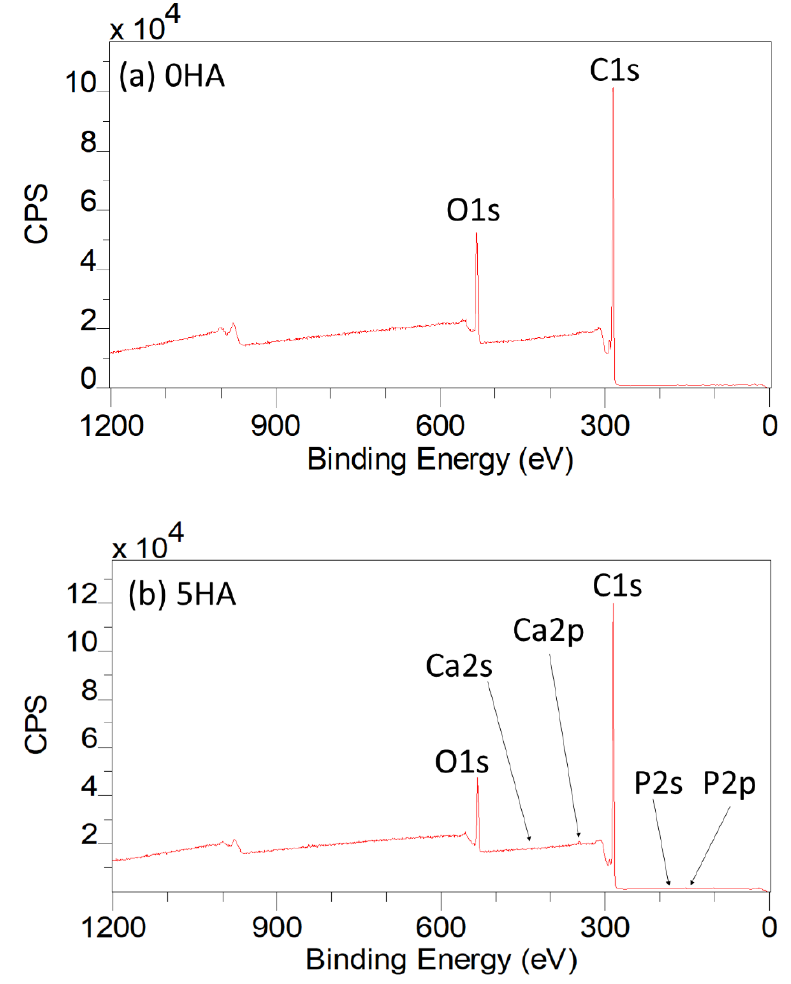
Figure 5. XPS wide Energy Survey Scans for ( a ) 0HA and ( b ) 5HA.